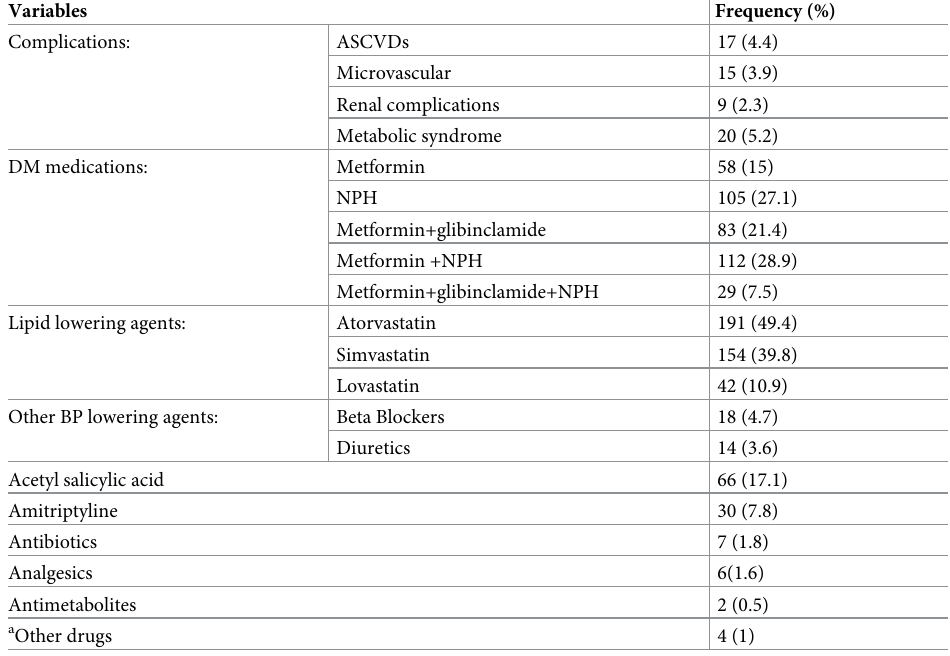
Table 2. Medical complications and medications types that the study subjects taking during the follow-up times.